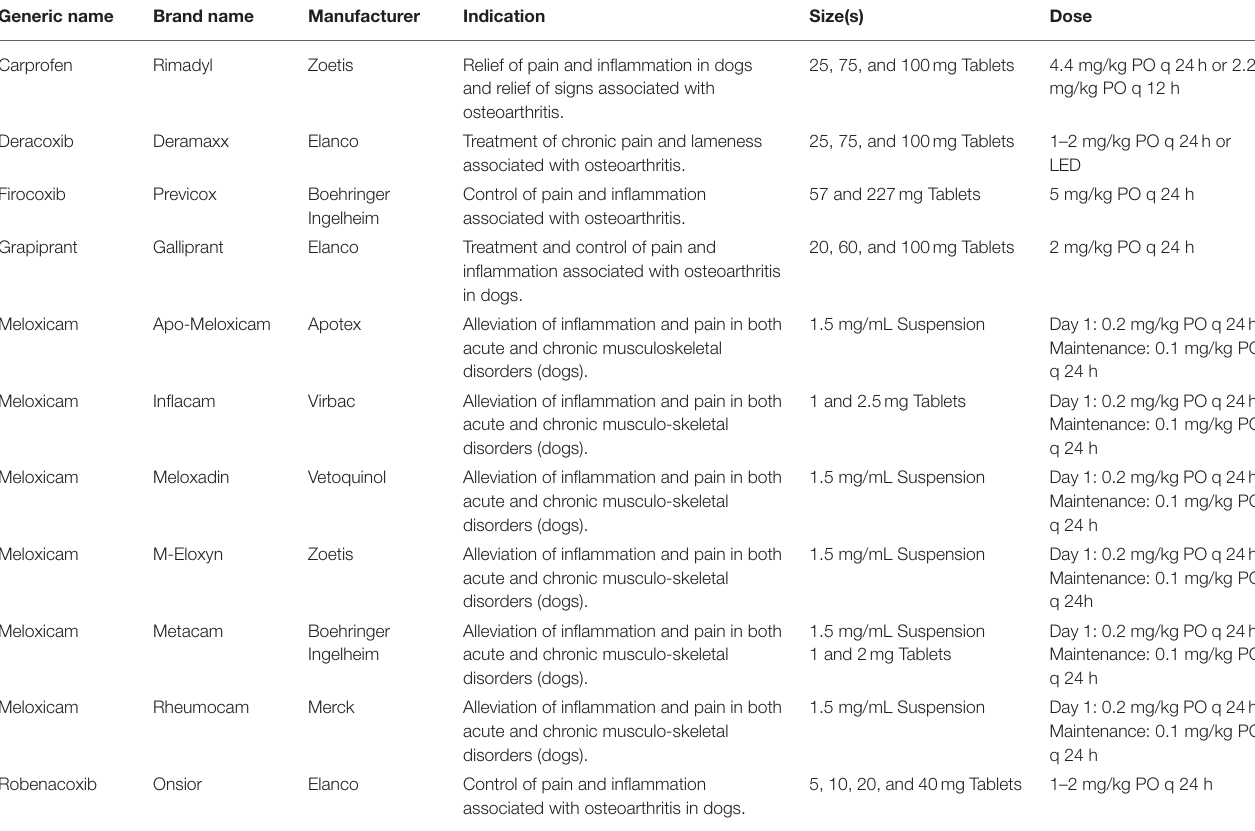
TABLE 3 | Non-steroidal antiinflammatory drugs available in Canada with label indication for OA. Generic